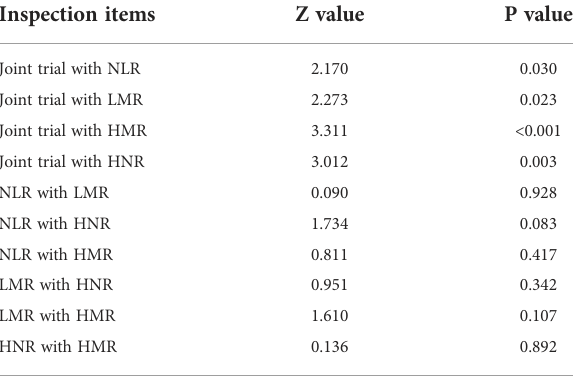
TABLE 4 The analysis of AUC area of NLR, LMR, HNR, HMR and Joint tests.